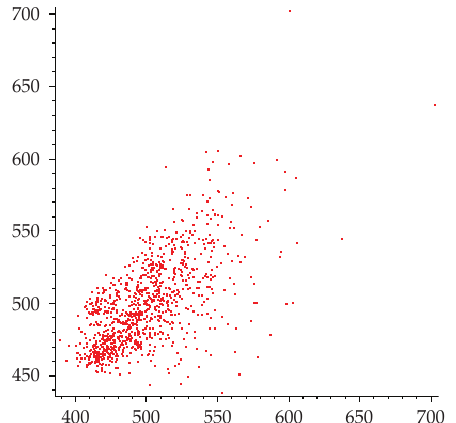
Figure 13: (cid:2) y (cid:2) t − 1 (cid:3) ,y (cid:2) t (cid:3)(cid:3) in the stochastic case for d (cid:7) 0 .